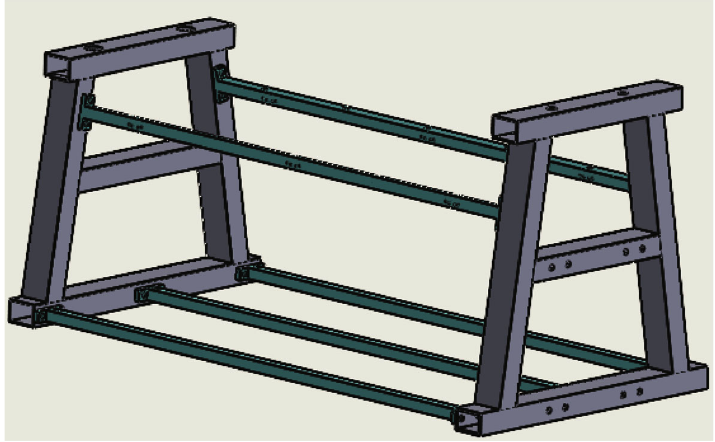
Figure 13: Frame.